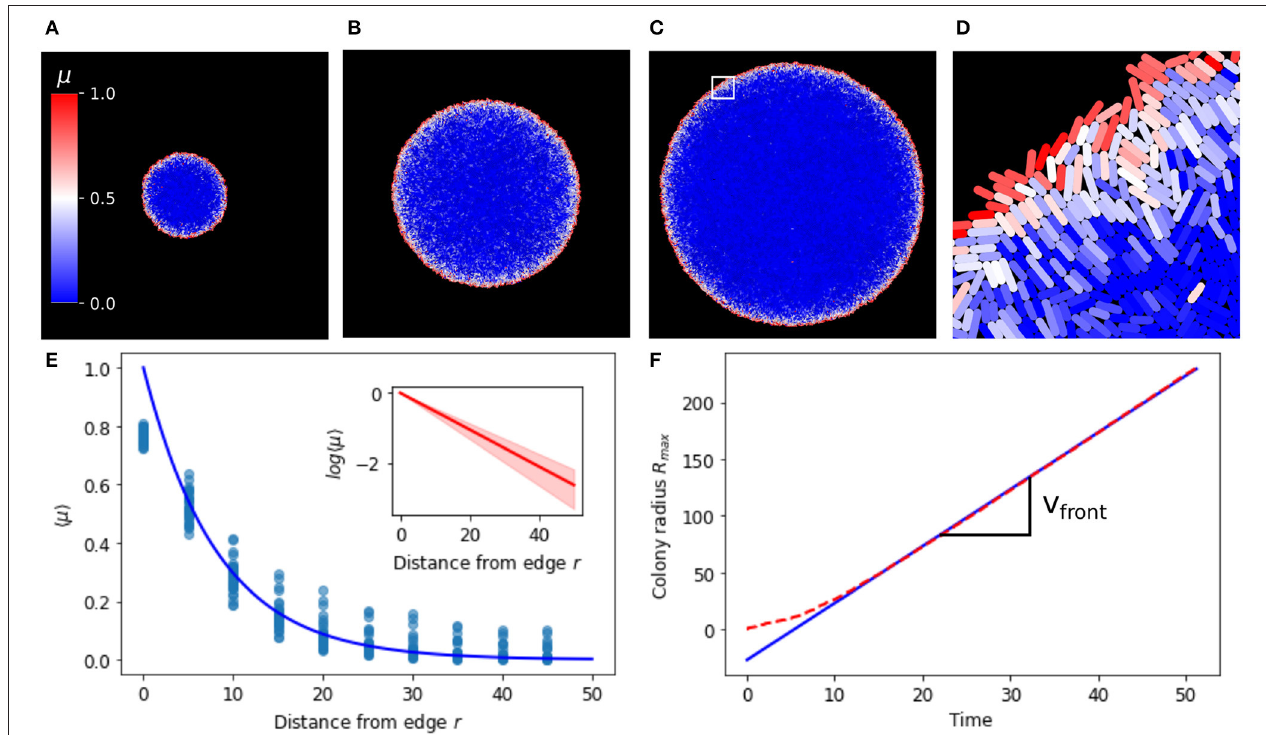
FIGURE 2 | Average growth rate decays exponentially with distance relative to the edge. (A–C) Are growing colonies at 5,000, 25,000 and 50,000 cells, respectively. (D) Is a zoom from the white square region in (C) . Single cells are colored according to their growth rate, which ranges between 0 and 1. (E) Average growth rate h µ i at different distances from the colony edge, blue line is an exponential function ( e − r / r 0 ) with r 0 = 8.23 fitted to the binned data (blue dots). Inset shows the log scale of the average growth rate h µ i at different distances from the edge. (F) Colony radius ( R max ) over time (dashed red line), linear fit to data at t > 10 giving v front = 5.00 the velocity of the colony edge (blue